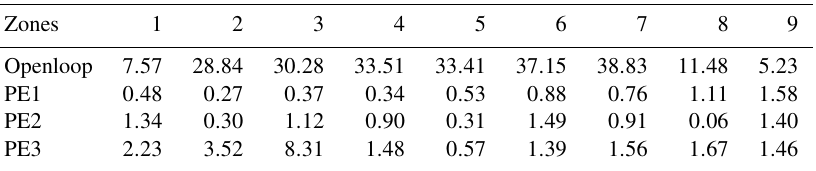
Table D1. Zone-averaged RMSEn for the openloop water depths (row 2) and the ensemble-averaged analysis water depths (rows 3–5) compared to the true water depths.